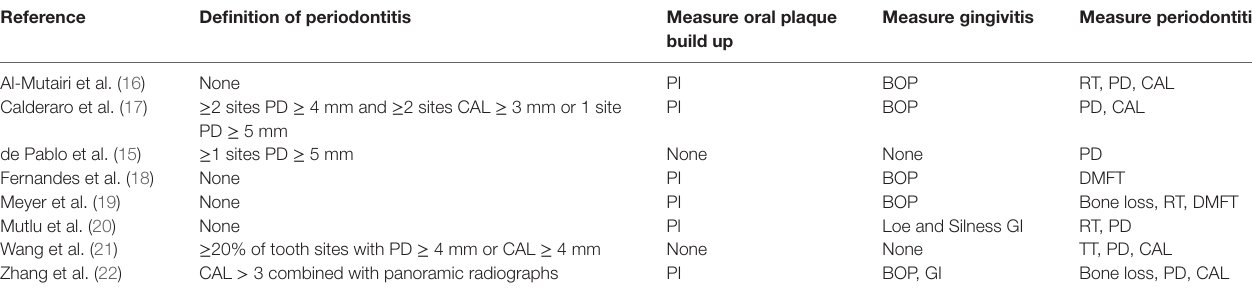
TaBle 4 | Definition of periodontitis and measures of periodontitis.